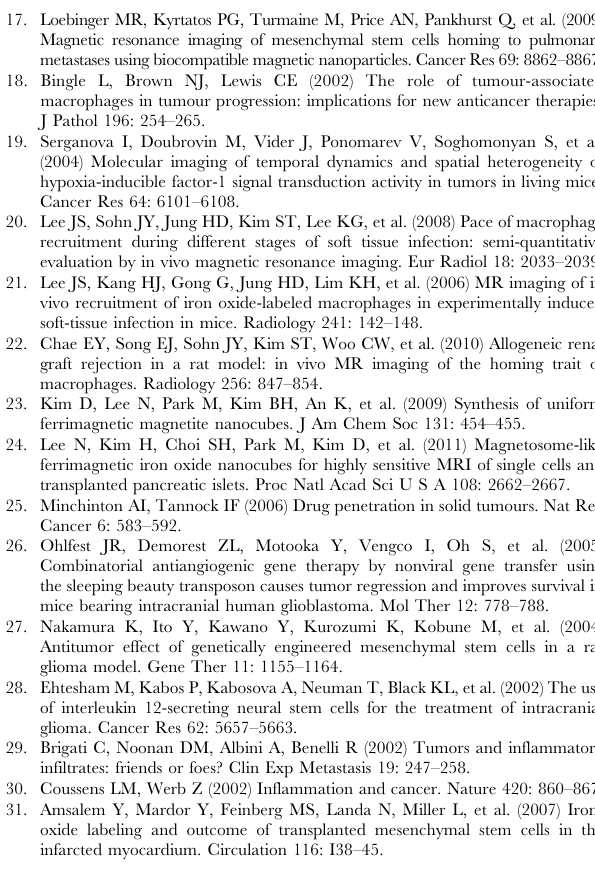
Figure S1 The Prussian blue staining of macrophages after incubation with various concentrations of iron oxide for different times. With increases in the concentration of iron oxide (from 12.5 to 100 m g Fe/mL) and exposure time (from 2 to 12 h), the macrophages phagocytosed more particles. When compared with Feridex-labeling, the FION-labeled macro- phages showed a higher intracellular uptake of iron after a 2 h- incubation period. Figure S2 The intracellular iron content (pg Fe/cell) after incubation with increasing iron oxide